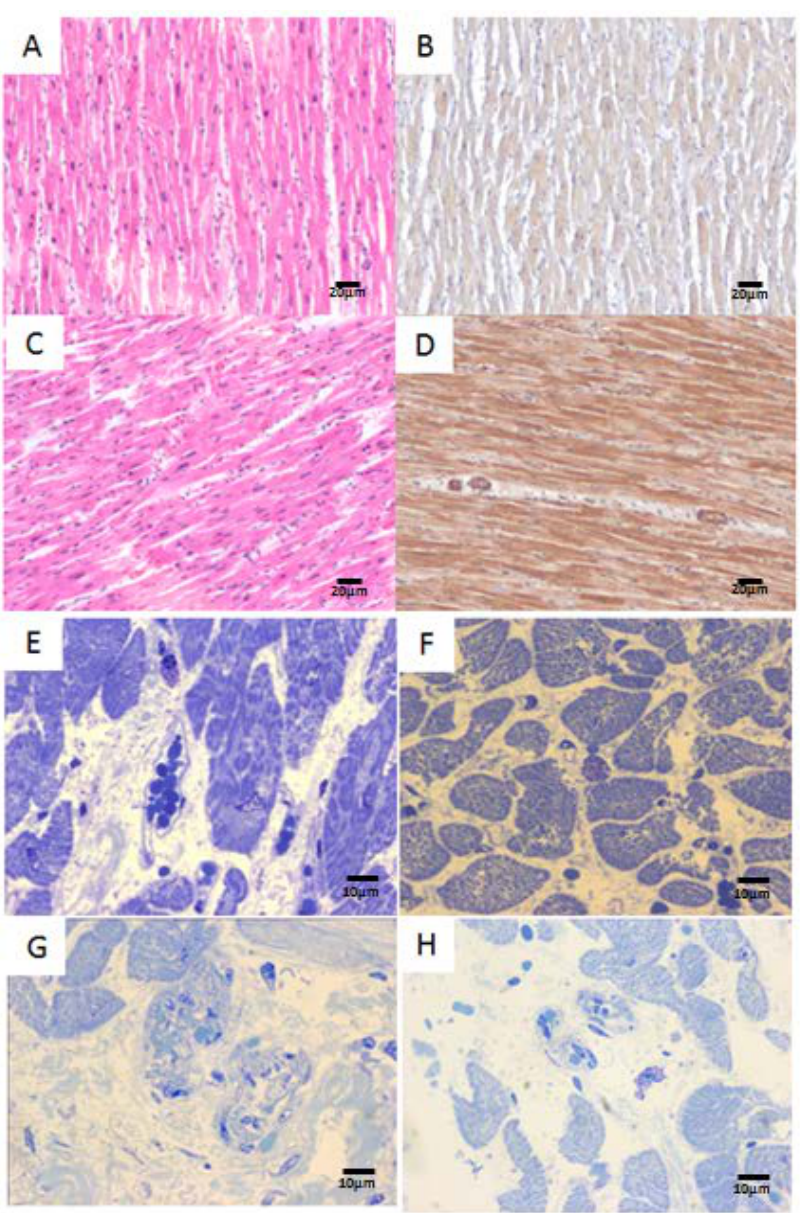
Figure 1. ( A ) The left ventricle in a 22 years old female control showing mild variation in nuclear size and unremarkable blood vessels. H&E ×40; ( B ) Same 22 years old control left ventricle with diffuse pale metallothionein immunostaining in myocardial fibers and negative staining in blood vessels, ×40; ( C ) Left ventricle in a 14 years old Mexico City girl with mild to moderate variation in nuclear size myocytes. H&E ×40; ( D ) Same exposed 14 years old girl left ventricle with metallothionein staining exhibiting stronger myocardial immunoreactivity, also involving endothelial and smooth muscle cells in arteriolar vessels, ×40; ( E ) A degranulated mast cell with clumping of nuclear chromatin is observed in this right ventricle from an 18 years old North MCMA male, Toluidine blue stain ×100; ( F ) In contrast, this 17 years control male shows intact fully granulated mast cells, Toluidine blue stain ×100; ( G ) Left ventricle in a 27 years old South MCMA male with sub-epicardial arterioles display thick walls, Toluidine blue stain ×100; and ( H ) Left ventricle in a 20 years male with unremarkable blood vessels, Toluidine blue stain